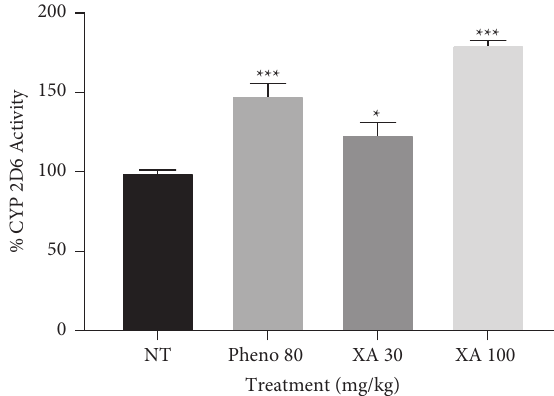
Figure 5: Effect of phenobarbitone (Pheno 80), xylopic acid low dose (30mg/kg; XA 30), and xylopic acid high dose (100mg/kg; XA 100), and ketoconazole (keto) on CYP 3A4 enzyme. Data are presented as mean ± S.E.M ∗∗∗ P < 0 . 001 compared to the no- treatment group (one-way ANOVA followed by Tukey’s post hoc test).